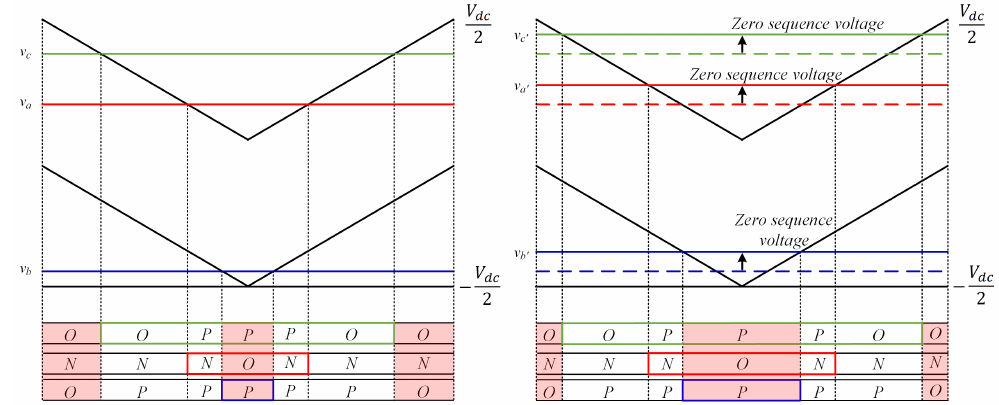
Figure 4. The duration time of the small vector ( OPP ) and ( NOO ) when the zero-sequence voltage is added.